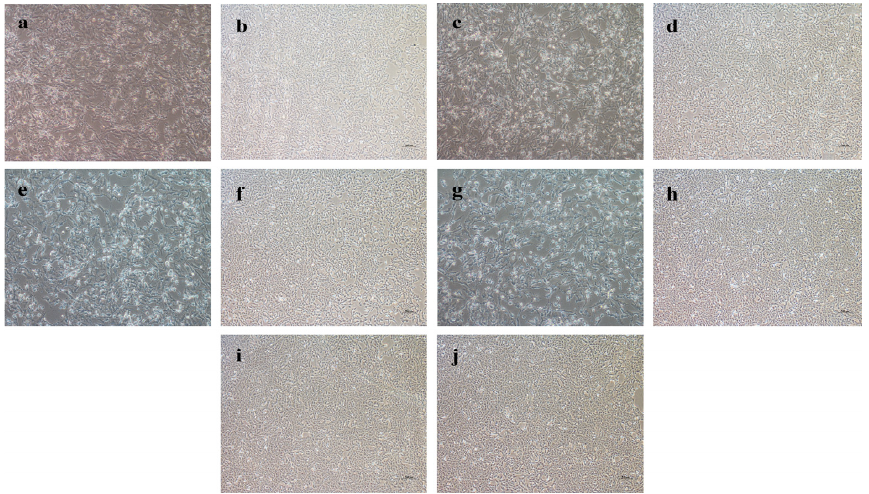
Figure 3. Identification of JEV isolates with specific serum. ( a ): CH/GD2011/2011 was inoculated; ( b ): CH/GD2011/2011 inoculation + positive serum treatment; ( c ): CH/GD2015/2015 was inoculated; ( d ): CH/GD2015/2015 inoculation + positive serum treatment; ( e ): CH/GD2014/2014 was inoculated; ( f ): CH/GD2014/2014 inoculation + positive serum treatment; ( g ): CH/GD2018/2018 was inoculated; ( h ): CH/GD2018/2018 inoculation + positive serum treatment; ( i ): positive serum control group; ( j ): blank control group (original magnification × 100).